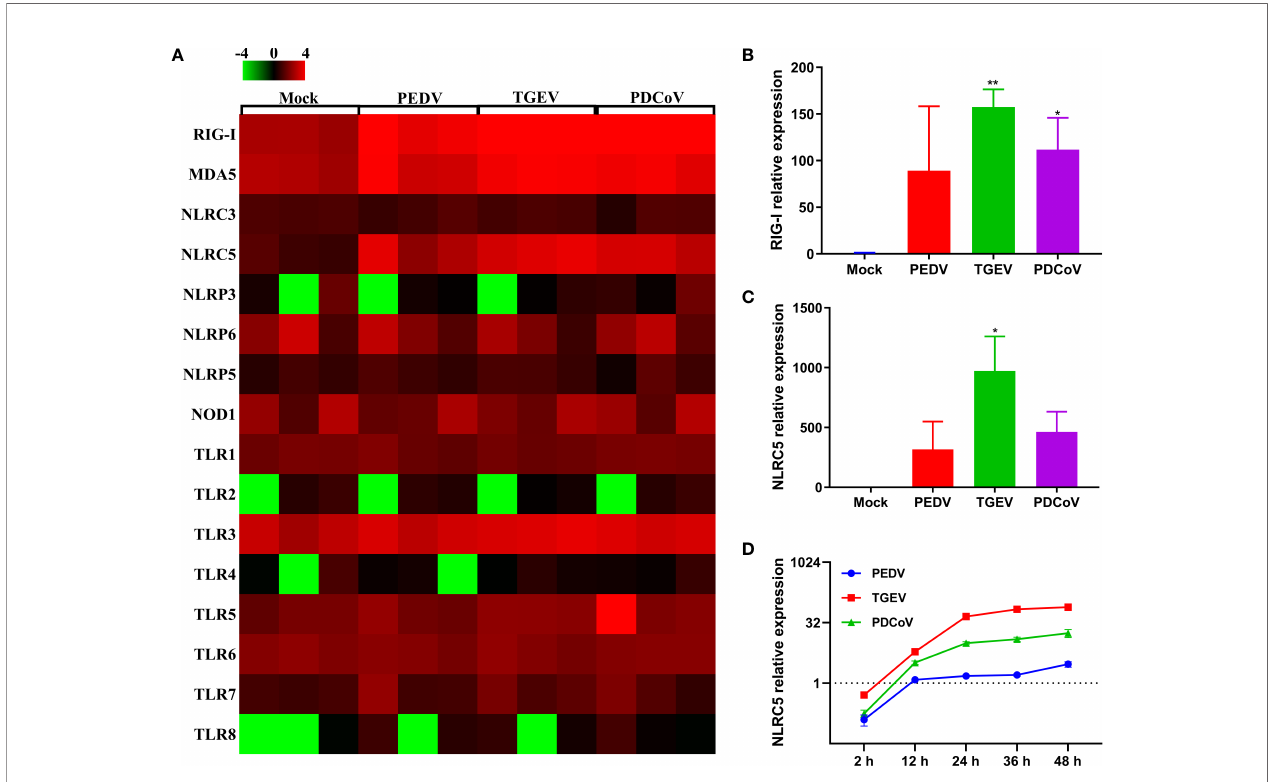
FIGURE 7 | The differential ability of SECoVs to manipulate PRRs and NLRs expression in enteroids. (A) Heat map of PRRs and NLRs expression in jejunal enteroids infected SECoVs. Total RNA was extracted from enteroids after infection with or without PEDV, TGEV, or PDCoV for 24 h, and the transcriptional pro fi les of PRRs and NLRs were determined by RNA-Seq. Data are based on log (RPKM) values (n = 3). (B-C). Veri fi cation of RIG-I and NLRC5 expression in jejunal enteroids by RT-qPCR. Monolayers of jejunal enteroids were infected with PEDV (MOI = 5), TGEV (MOI = 1), or PDCoV (MOI = 2) for 24 h, and the mRNA levels of RIG-I (B) and NLRC5 (C) were detected by RT-qPCR. Data represent the means ± SEMs (n = 3). The differences between groups were compared using the Student ’ s t test. Error bars denote the deviations, and the p values are expressed as follows: * p < 0.05, and ** p < 0.01. (D) The expression kinetics of NLRC5 in jejunal enteroids after SECoVs infection. Following PEDV, TGEV, or PDCoV infection, jejunal enteroid monolayers were collected at the indicated time points for the quanti fi cation of NLRC5 expression by RT-qPCR. The scale data of panel D were taken as log 2 (fold change)